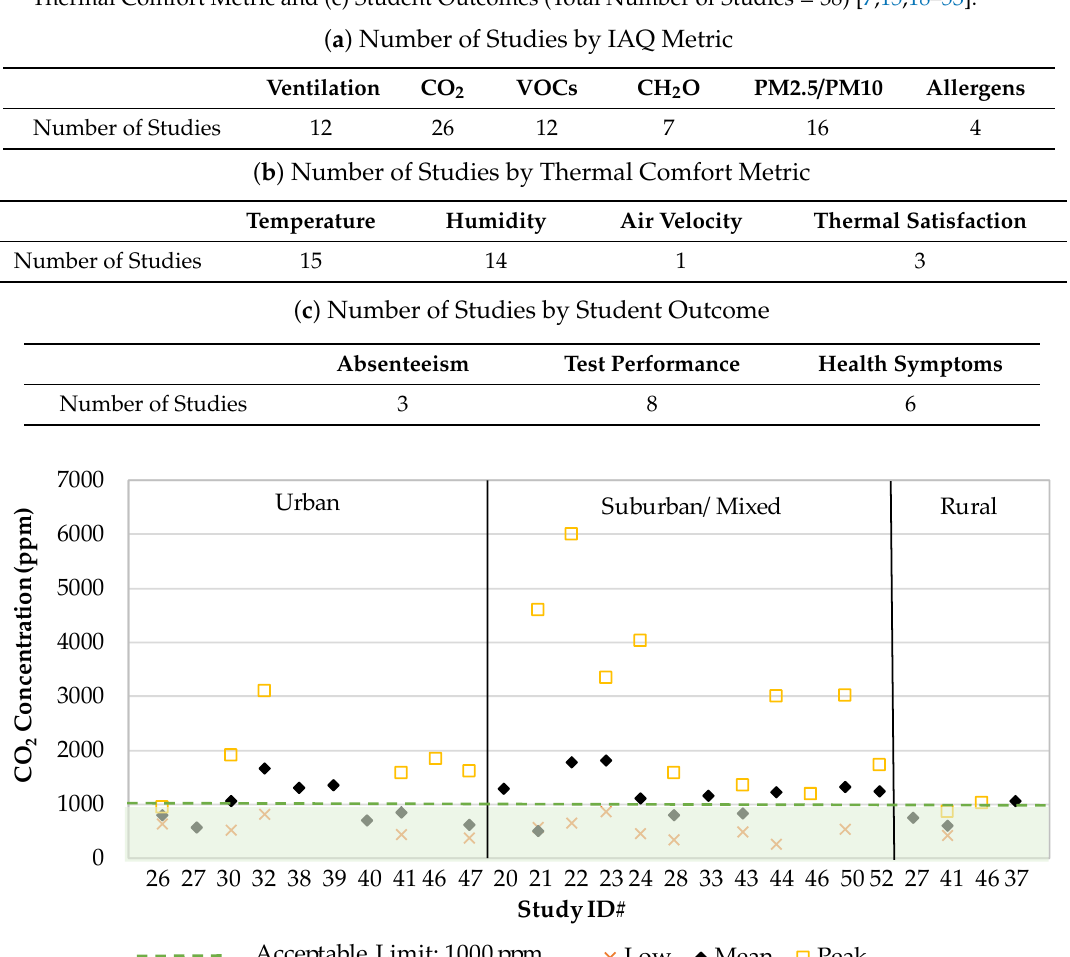
Figure 1. Low, Mean, and Peak CO 2 of the Selected Studies by Environment Type.